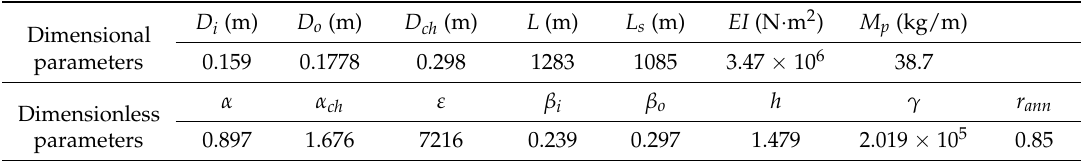
Table 1. Sample properties of real-life leaching tubings and associated dimensionless parameters [1]. Dimensional